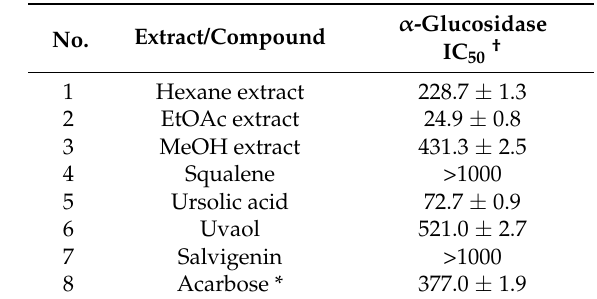
Table 2. In vitro α -glucosidase inhibitory effect (as IC 50 values) of extracts and compounds isolated from Clinopodium taxifolium